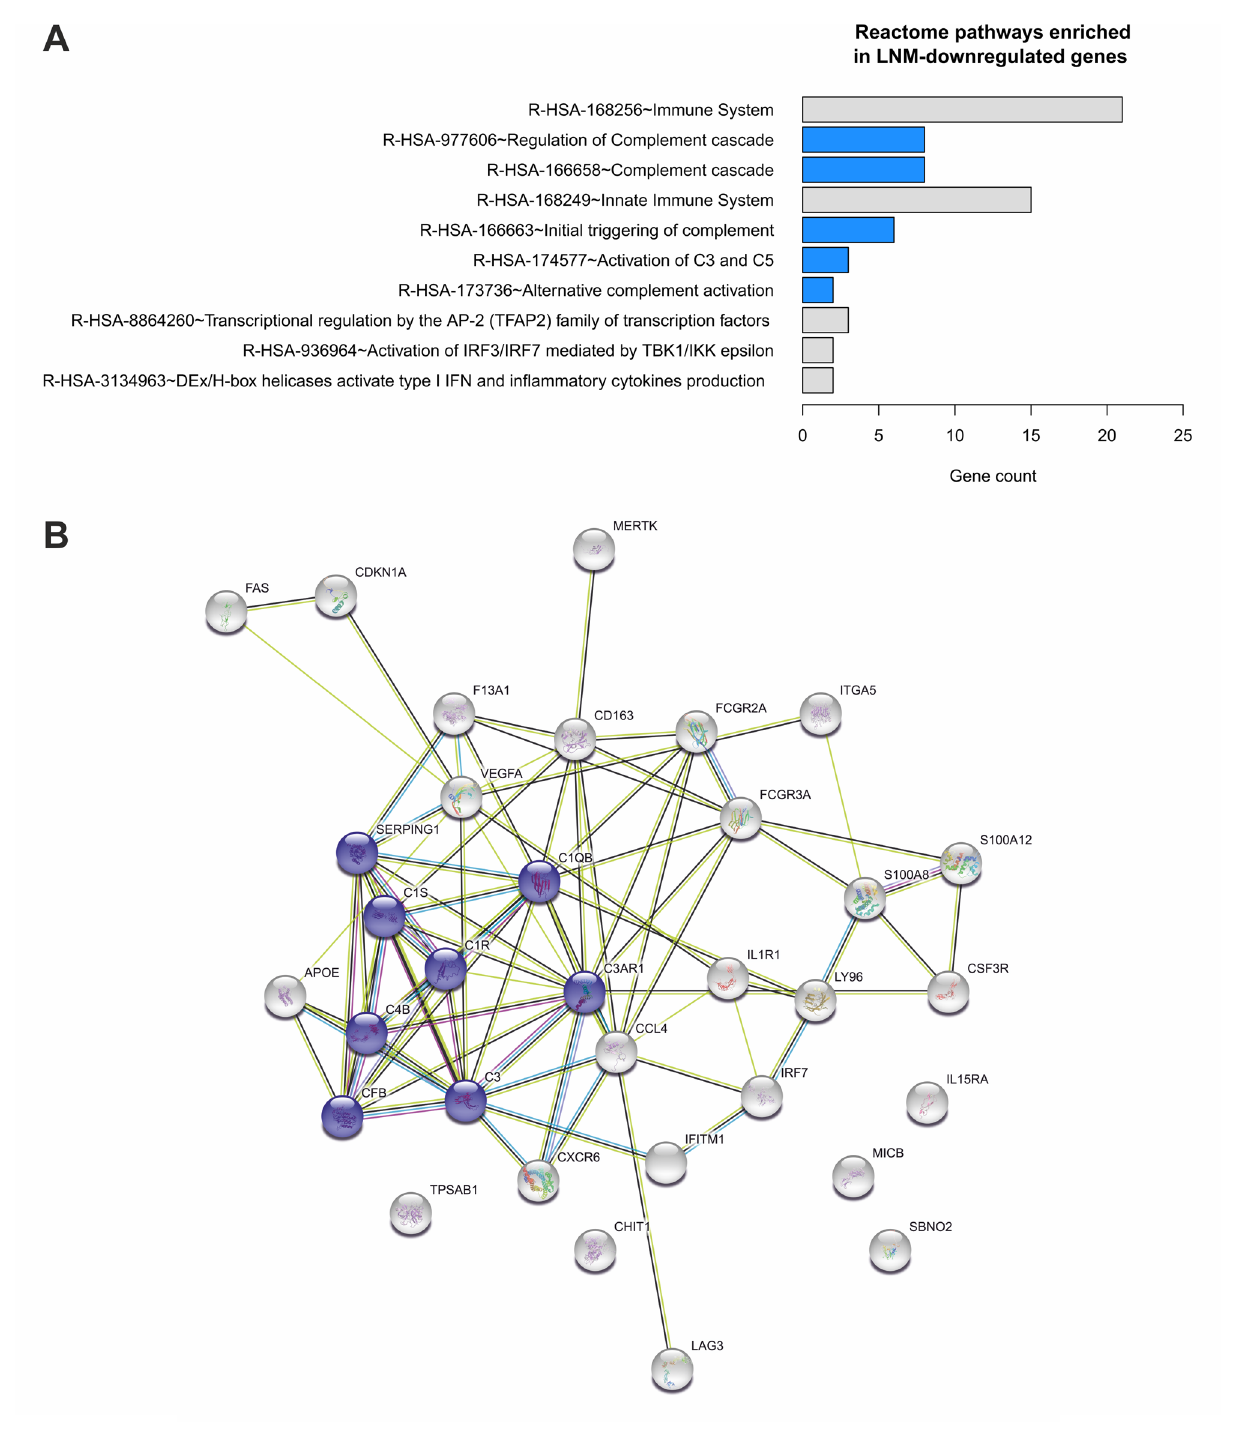
Figure 3. LNM-downregulated genes are associated with the complement system. ( A ) ConsensusPathDB over- representation analysis [pathways ordered according to − log 10(FDR adjusted p value), complement-related pathways marked in blue] and ( B ) STRING protein interaction analysis (complement-related protein products marked in